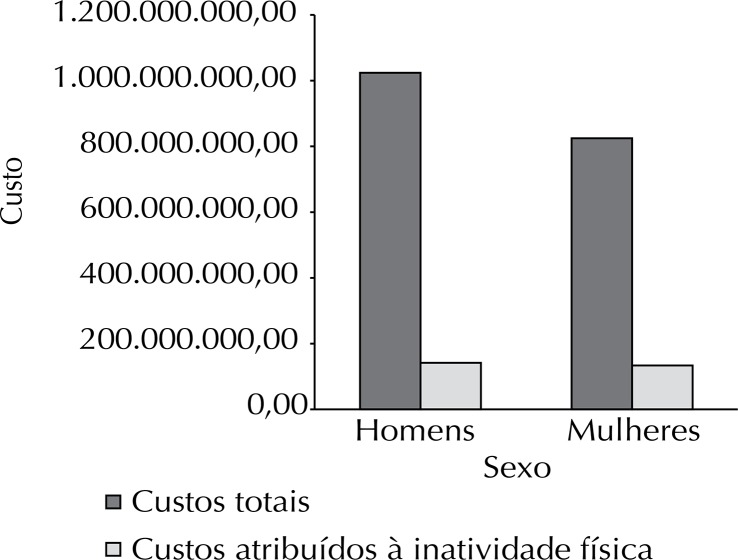
Custos totais (R$) ao Sistema Único de Saúde devido às hospitalizações por neoplasia de cólon e mama, doenças isquêmicas do coração e cerebrovasculares, hipertensão, diabetes e osteoporose e valor atribuível à inatividade física de homens e mulheres. Brasil, 2013.